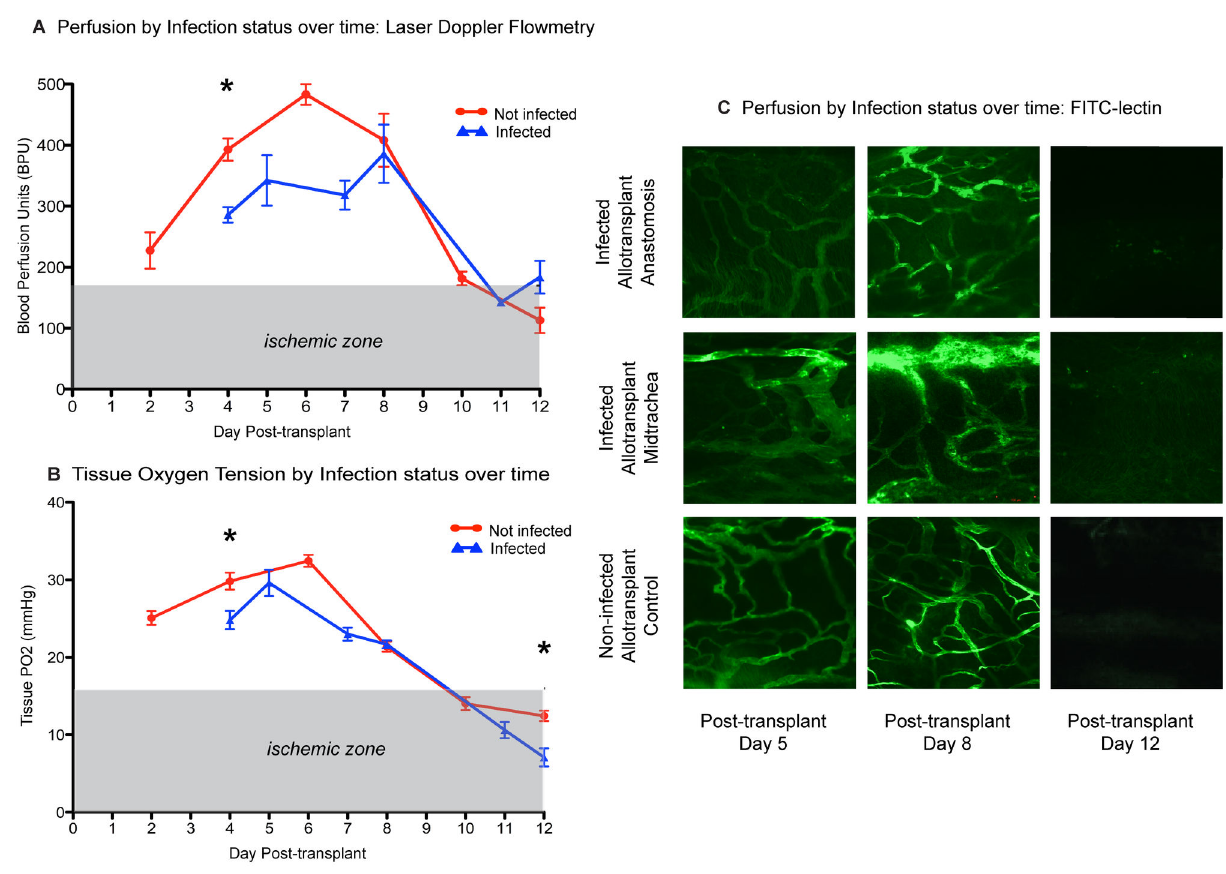
Figure 4. Infected and non-infected allografts share similar overall blood perfusion and luminal tissue oxygen kinetics. All measurements represent pooled data from animals on post-infection days 1 and 2. ( A ) Blood perfusion measurements (mean +/- SEM, BPU) plotted over time (n = 4-8 animals/time point) in infected (blue) and non-infected (red) allografts. Both show similar overall blood perfusion kinetics with an initial increase in graft perfusion followed by progressive microvascular ischemia between day 8 and day 12. “Ischemic zone” is based on previous studies [18] denoted by shaded area. ( B ) Tissue pO measurements (mean 2 +/- SEM, mmHg) plotted over time (n = 4-7 animals/time point) in infected (blue) and non-infected (red) allografts, demonstrating similar overall tissue pO kinetics regardless of infection status. “Ischemic zone” is based on previous studies [18] denoted by 2 shaded area. *p <0.05. ( C ) FITC-lectin perfusion profile of whole-mount tracheal grafts on days 5, 8, and 12 post-transplantation by infection status. Lower row represents non-infected allograft perfusion at donor-recipient anastomosis. For animals at day 5 and 8, the middle row depict microvasculature of the midtrachea in the infected allograft, demonstrating dilated vasculature compared with the vessels at the anastomosis (top row). Day 12 animals experience profound loss of microvasculature. doi: